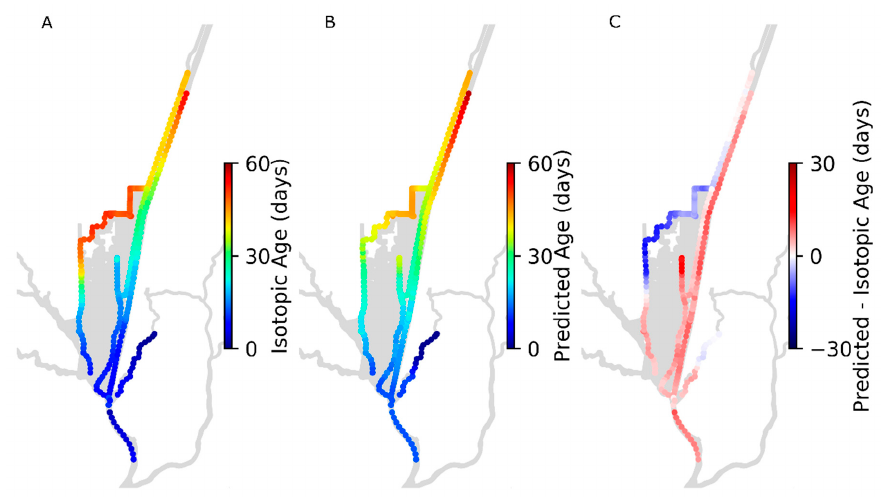
Figure 7. ( A ) Water age estimated from stable isotope observations; ( B ) hydrodynamic model predicted water age; ( C ) difference between predicted and isotopic water age. Water 2019 , 11 , x FOR PEER REVIEW